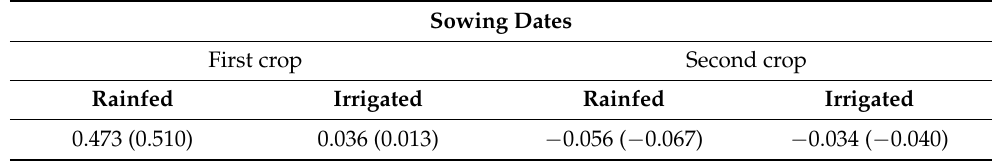
Table 2. Pearson correlation coefficient of rainy season onset and sowing dates in Western